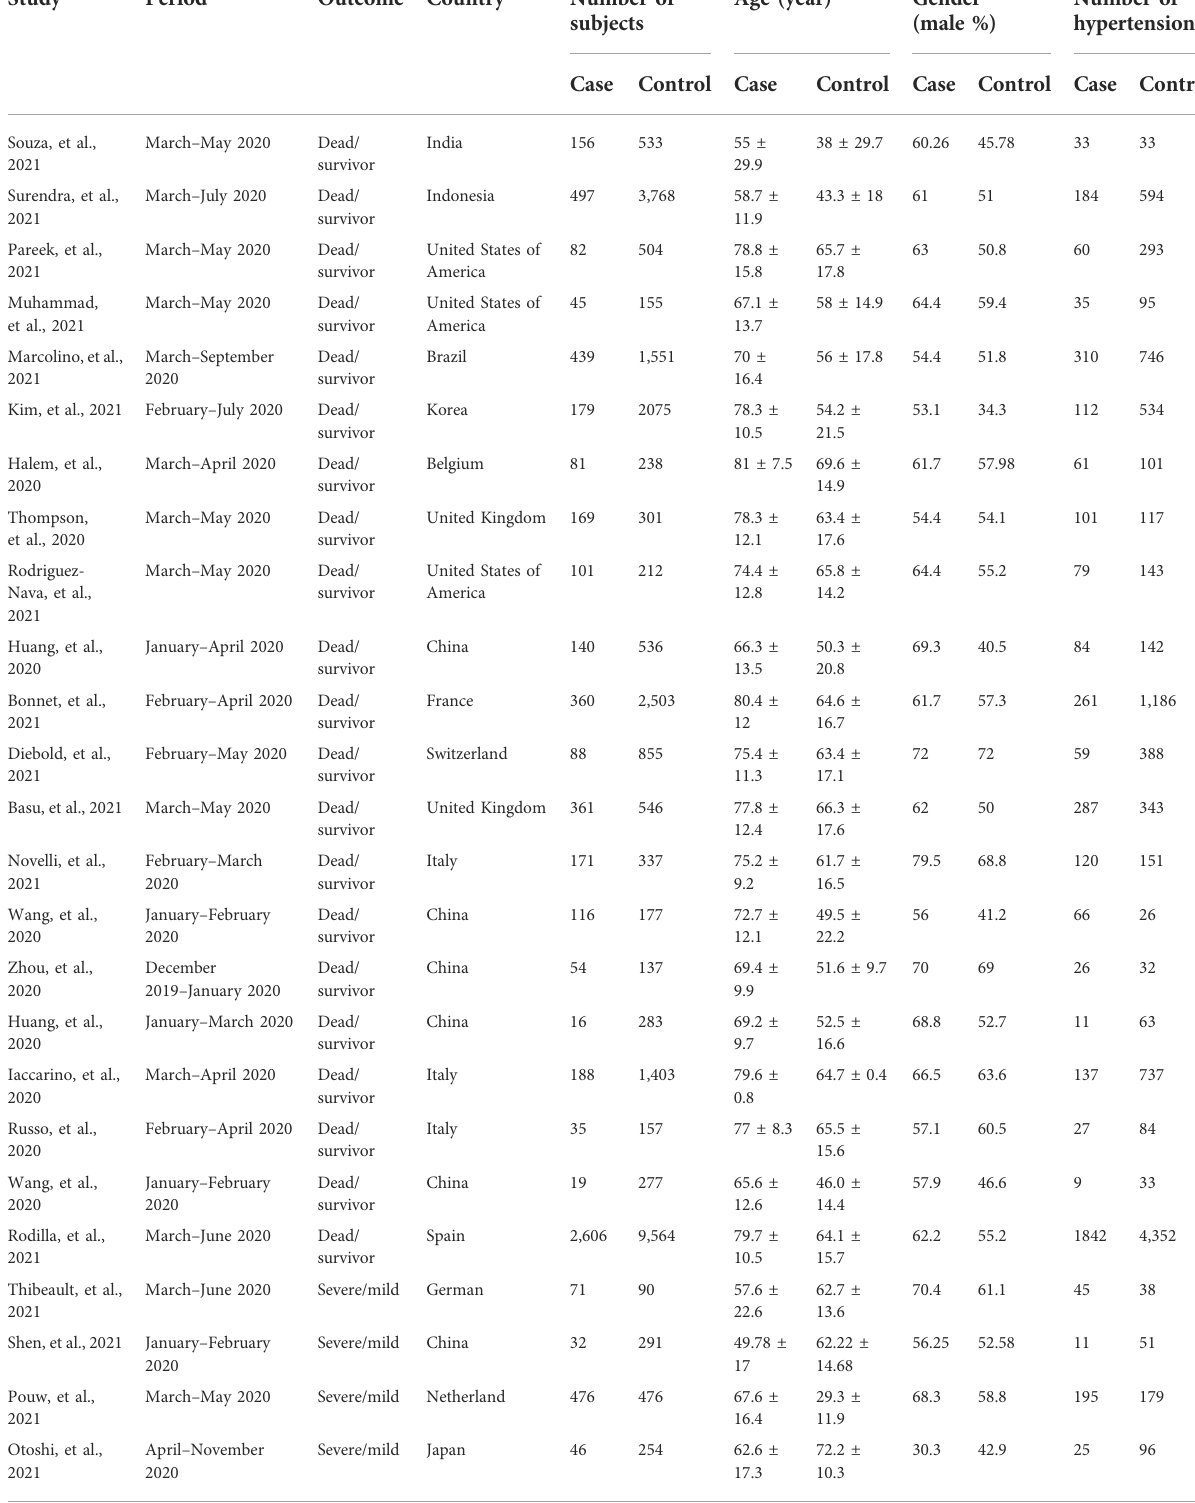
TABLE 1 Characteristics of studies included in the current